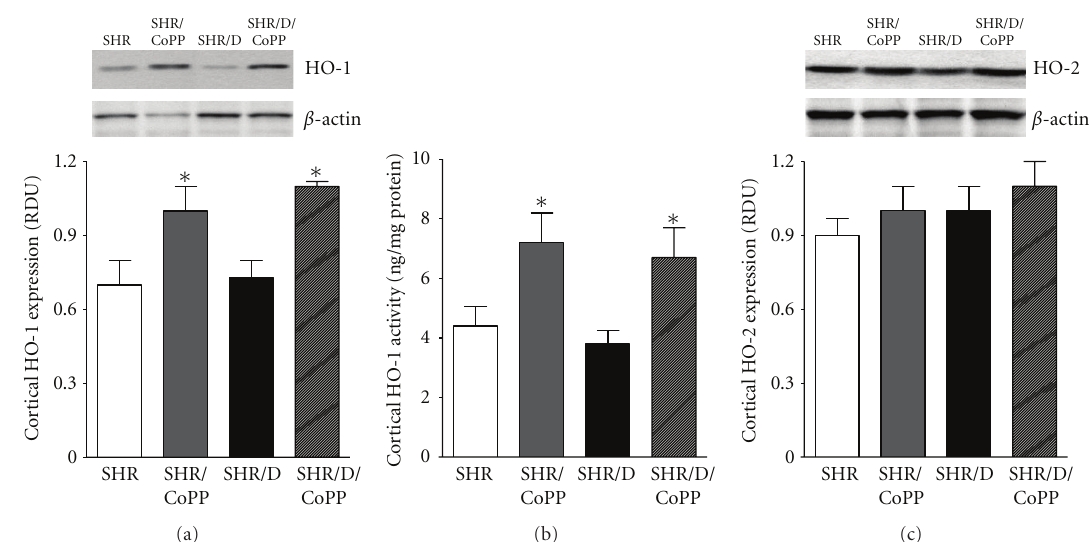
Figure 1: Renal cortical HO-1 expression relative to β -actin (a), HO-1 activity (b), and HO-2 expression relative to β -actin (c) in control and diabetic (D) SHR with or without CoPP treatment ( n = 6, ∗ indicates significant di ff erence from control SHR and # indicates significant di ff erence from diabetic